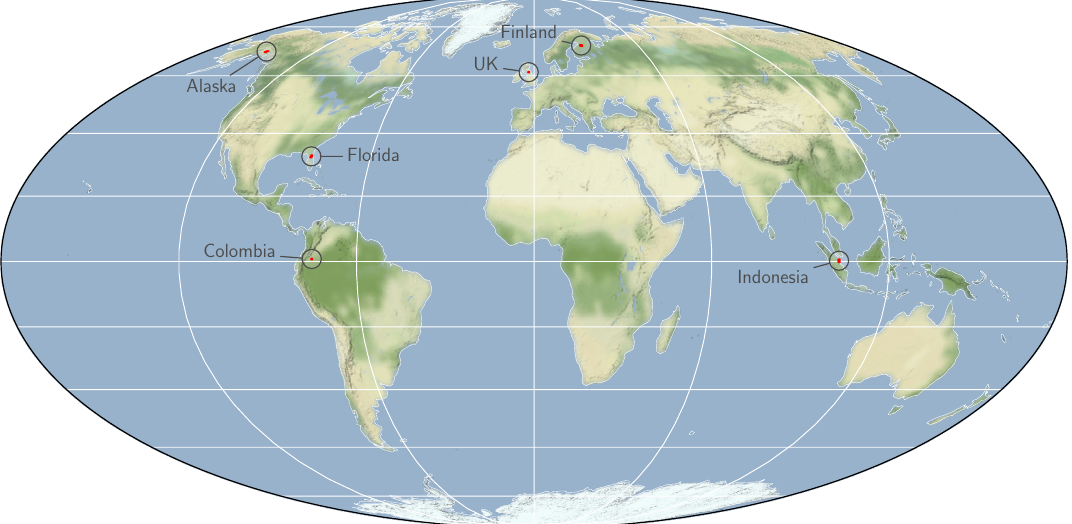
Figure 1. This figure shows all six areas that were chosen for the separability study on a single map. The exact locations are marked with red polygons, with annotations to help locate them